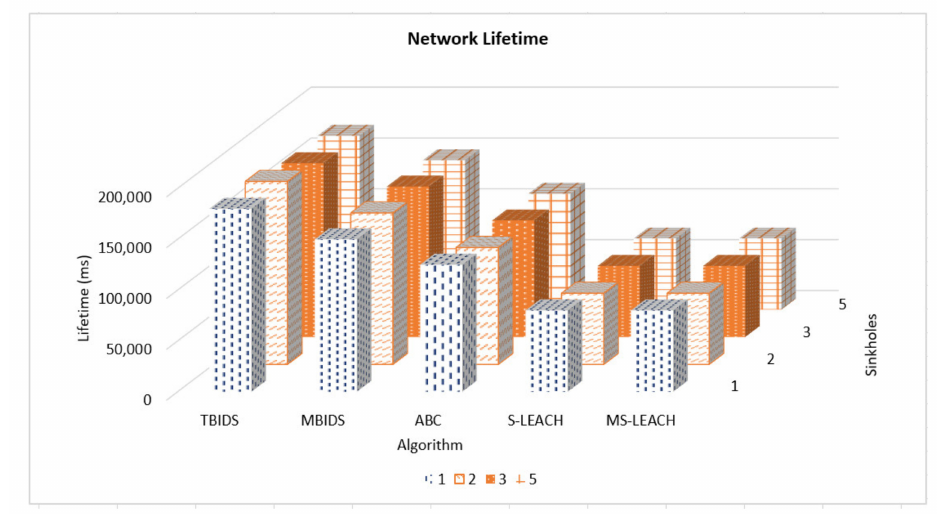
Figure 16. Lifetime for large-scale